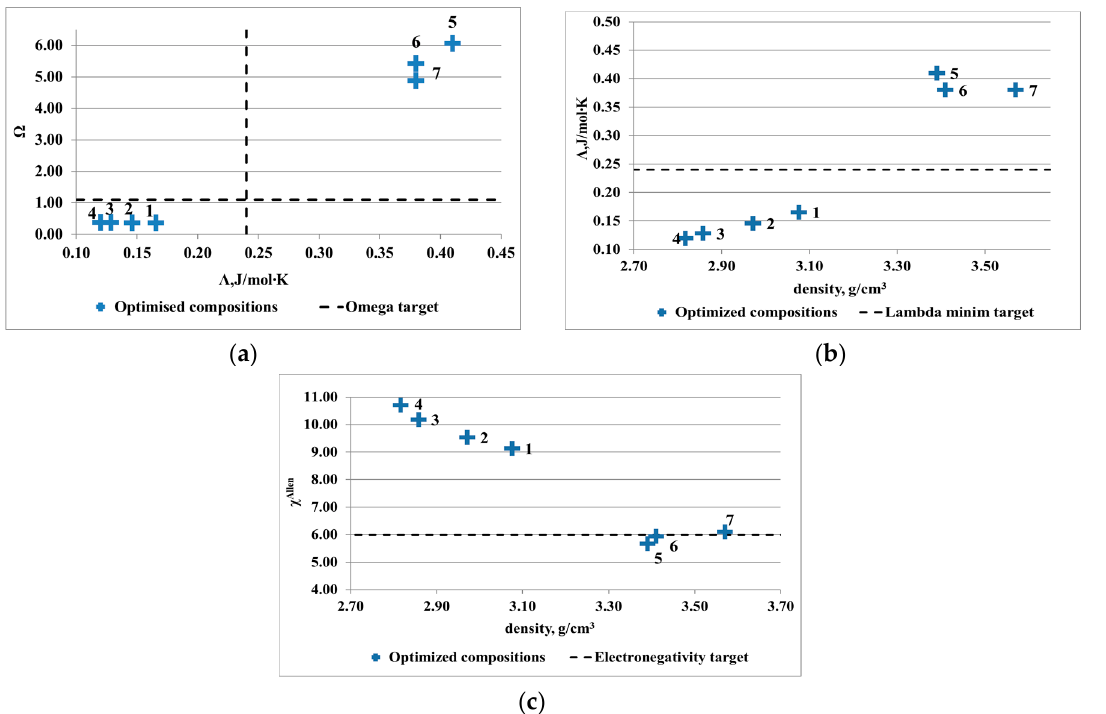
Figure 4. Results of criteria multiobjective optimization for Al-Mn-Zn-Mg-Si system: ( a ) Λ versus Ω , ( b ) Λ versus density, and ( c ) ∆ χ Allen versus density.